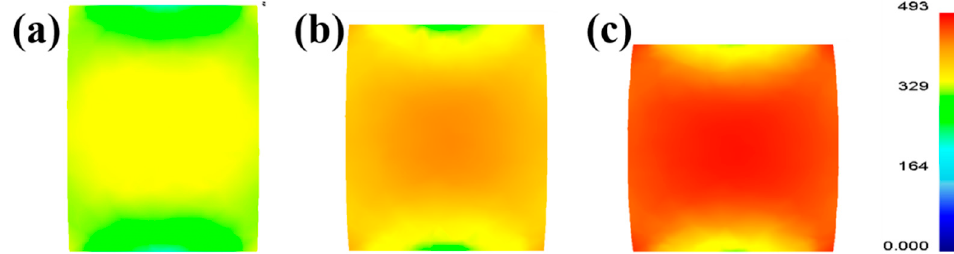
Figure 5. Stress distribution clouds for semi-solid CuSn10P1 alloy copper at different levels of compressive deformation: ( a ) ε = 0.1, ( b ) ε = 0.2, ( c ) ε = 0.3.